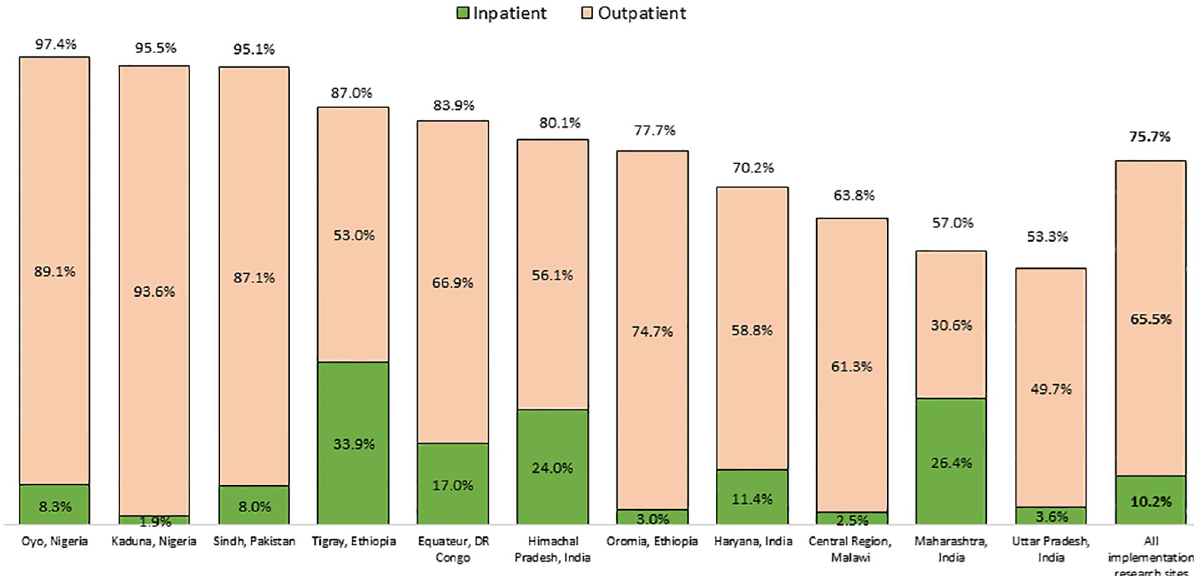
Fig 1. Estimated coverage of possible serious bacterial infection (PSBI) treatment by site, overall and as inpatients or outpatients.